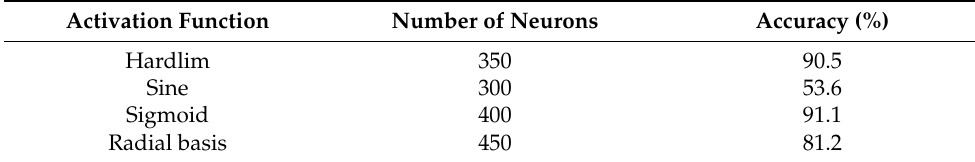
Table 1. Accuracy of different activation functions and number of neurons.